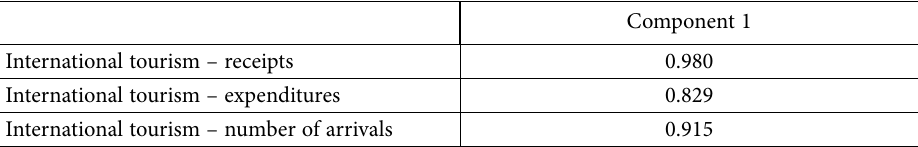
Figure 2. The main principals’ components based on the financial determining factors (source: own computations using EViews Table 4. Component Matrix (source: own computations using EViews 10)